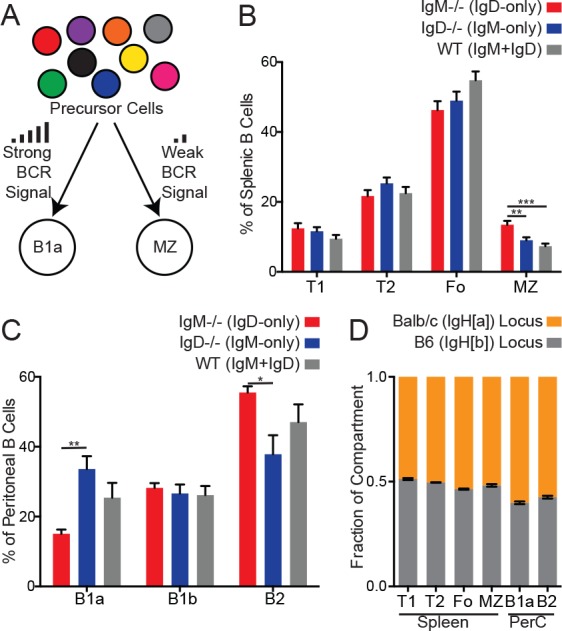
B cell subset development in IgM−/−, IgD−/−, WT, and IgHa/b mice.(A) Signal strength model of B1a and MZ B cell development. While B1a and MZ cells originate from different precursor populations, their development is thought to be BCR signal strength-dependent. (B) B cell compartments as a percentage of total B220+ splenic B cells. T1 (CD93+CD23-); T2/3 (CD93+CD23+); Fo (CD93-CD23+); MZ (CD21hiCD23lo). (C) B cell compartments as a percentage of total CD19+ peritoneal B cells. B1a (CD5+CD23-); B1b (CD5-CD23-); B2 (CD5-CD23+). (D) Relative competition between IgMa+ and IgMb+ B cells in Balb/c-B6 F1 mice was calculated for splenic and peritoneal compartments described in (B–C). For (B), n = 10–12 mice of each genotype were analyzed. For (C), n = 6 mice of each genotype were analyzed. For (D), n = 3 mice were analyzed. Mice in (D) were 6–14 weeks old. One-way ANOVA with Tukey’s multiple comparisons test (B-C) was used to calculate p values, and mean ±SEM is displayed. *p<0.05, **p<0.01, ***p<0.001.